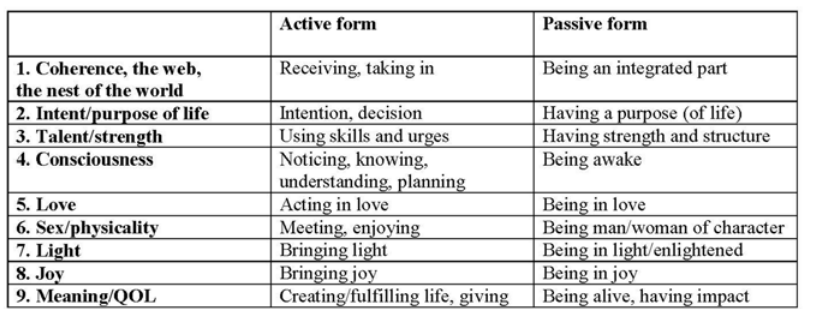
Table 1. The Nine Key Dimensions Of